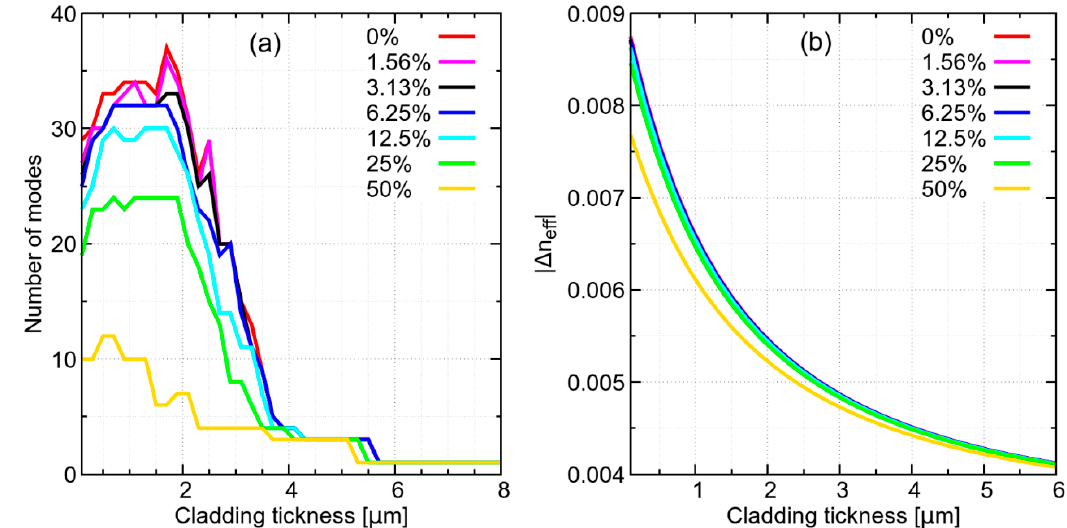
Figure 2. ( a ) Calculated number of modes, and ( b ) effective index distance between fundamental mode (FM) and first HOM, varying cladding thickness and sucrose concentration from 0% to 50% (weight/volume) in aqueous solution.